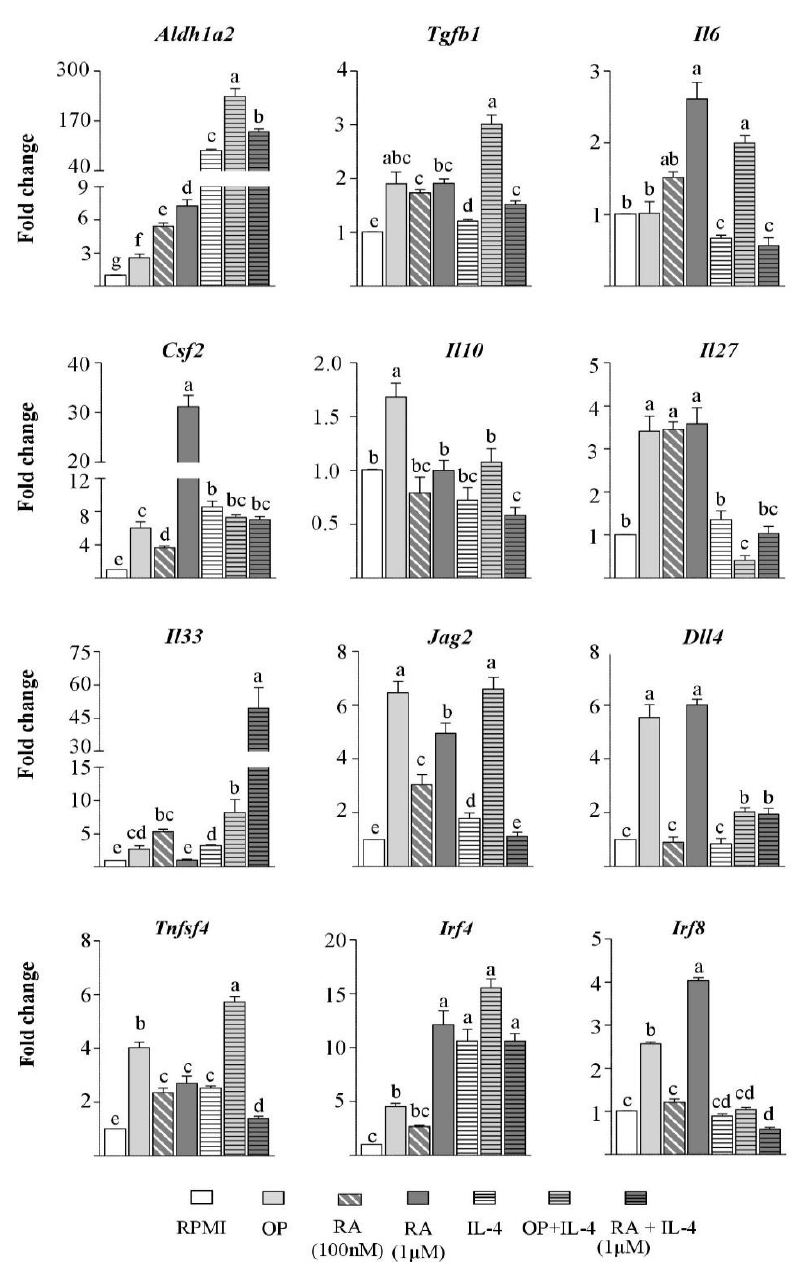
Figure 1. Bone marrow-dendritic cells (BM-DCs) pulsed with ovalbumin with pepsin (OP) acquire tolerogenic features. BM-DCs from naïve mice were cultured for 24 h without stimuli (RPMI), or with OP, retinoic acid (RA), IL-4, OP + IL-4, or RA + IL-4. Gene expression of Aldh1a2 , Tgfb1 , Il6 , Csf2, Il10 , Il27, IL33 , Jag2, Dll4 , Tnfsf4, Irf4 , and Irf8 was assayed by quantitative polymerase chain reaction (qPCR), normalised to the reference gene Actb , and expressed relative to BM-DCs cultured in RPMI. Results of an experiment representative of, at least 3, separate experiments performed in triplicate are shown. Data are means ± standard error of the mean (SEM). Different letters indicate statistically significant differences ( p < 0.05) calculated using the Mann–Whitney U test.